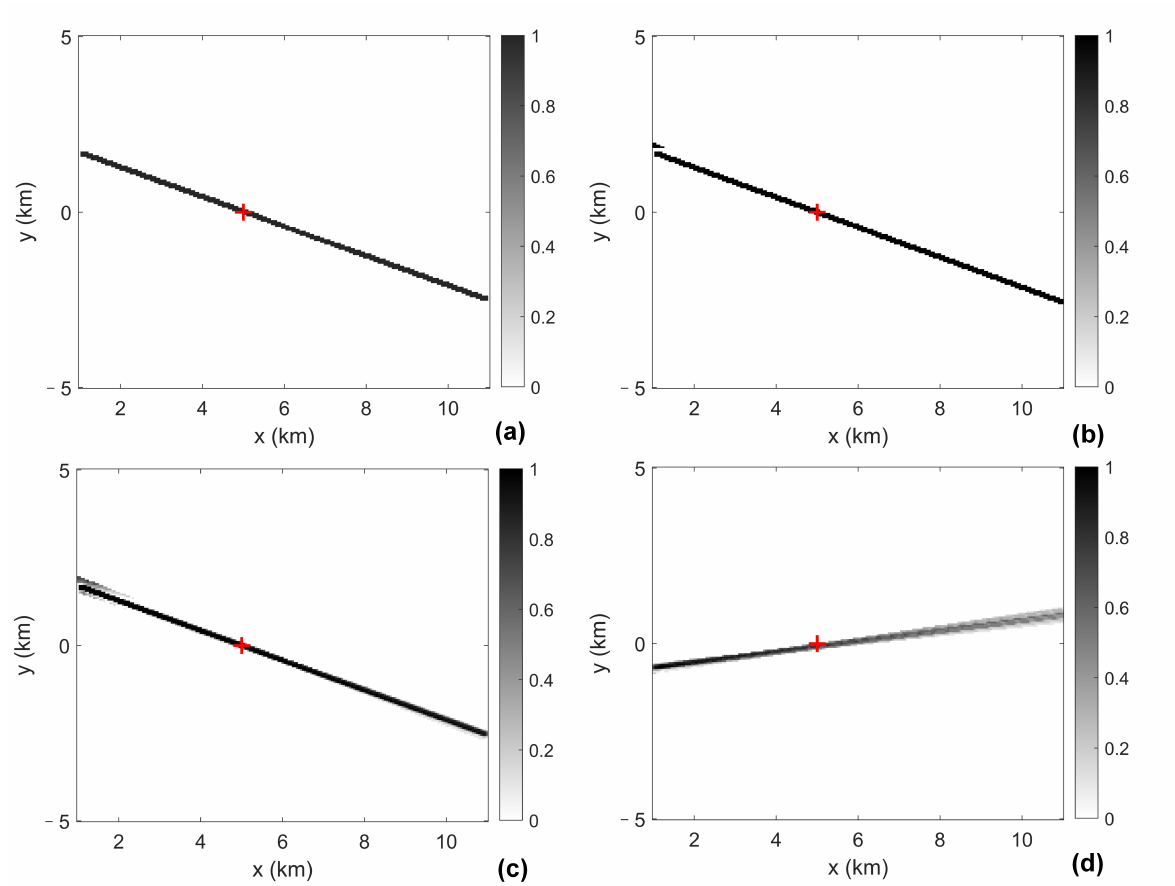
Figure 6. (Color online) ( a , b ) The recovered narrowband mainlobe peaks of 112 Hz and 176 Hz of array 1; ( c , d ) The fusion of the recovered narrowband mainlobe peaks of array 1 and 3. The red plus markers indicate the true position of the target.